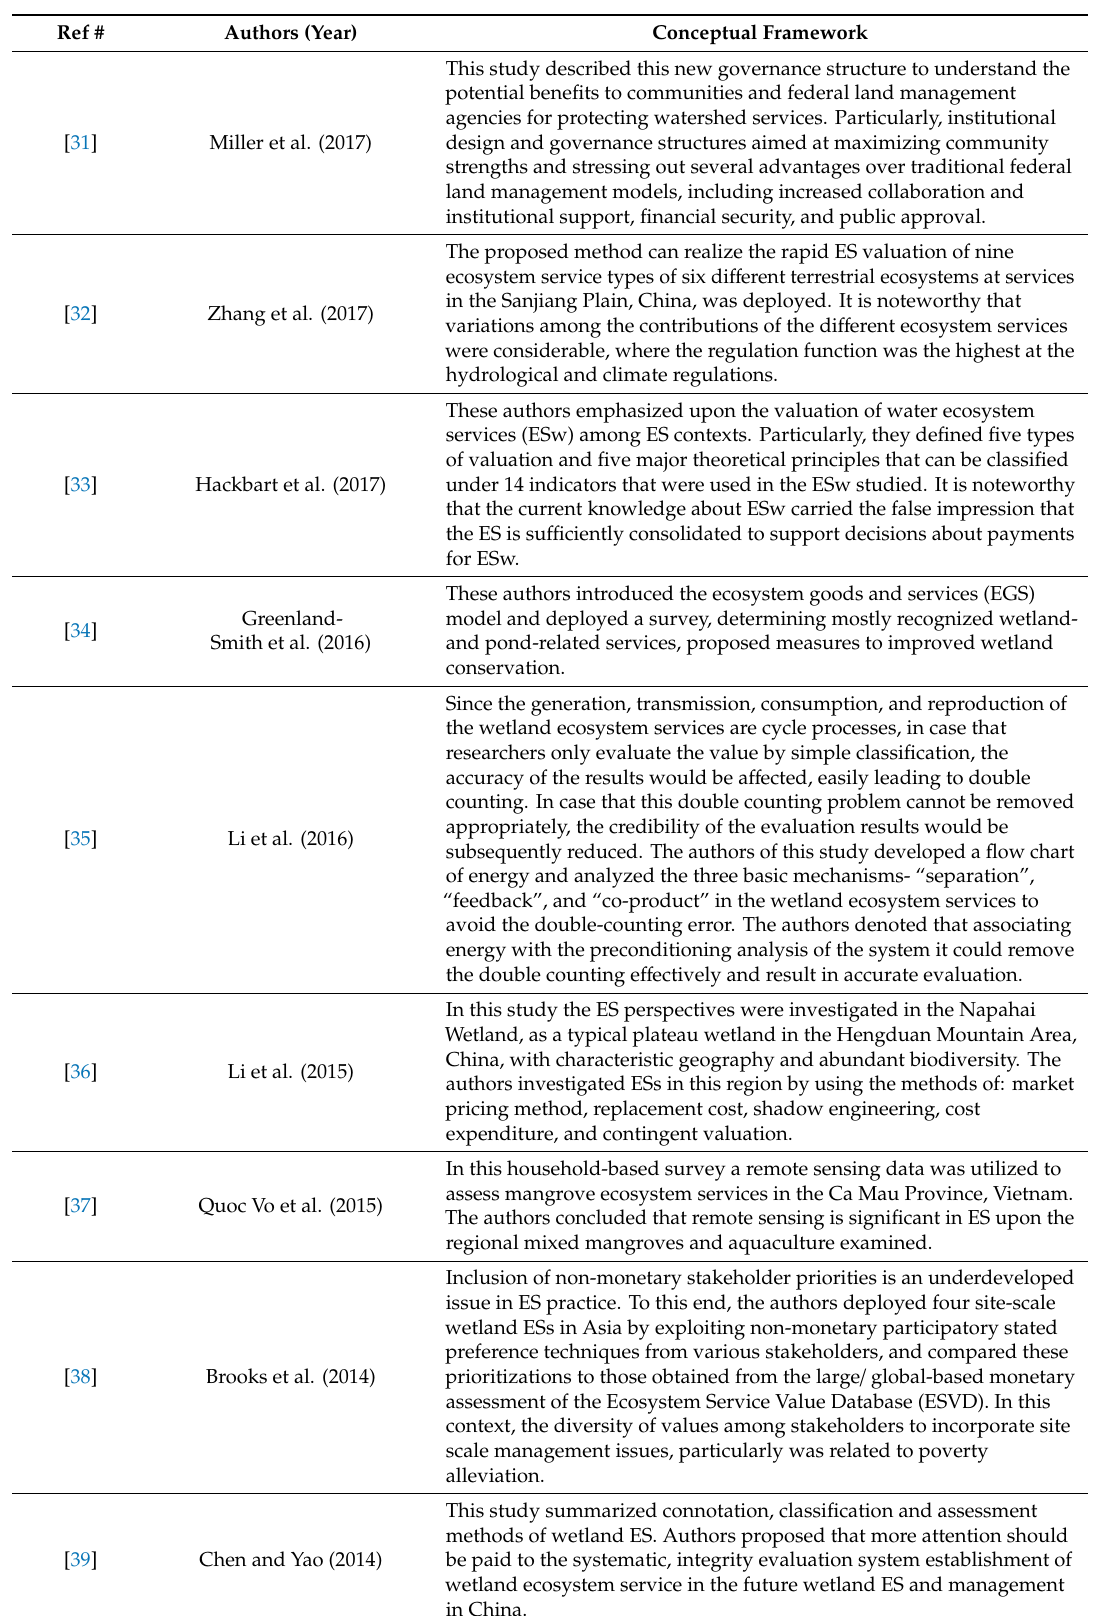
Table 2. Literature overview of valuing ES under the thematic classification of “regulatory and maintenance